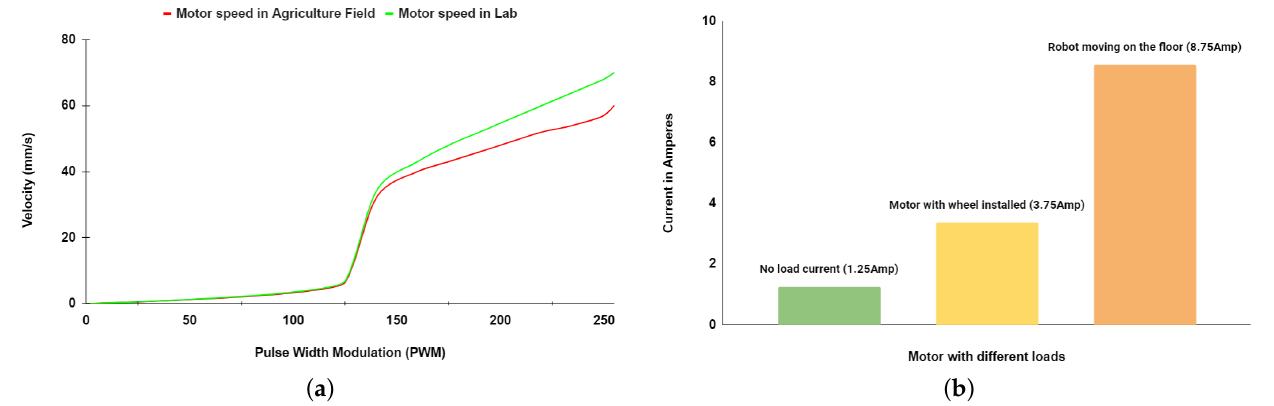
Figure 11. ( a ) Velocity as a function of pulse width modulation (PWM); ( b ) power consumption with load and without